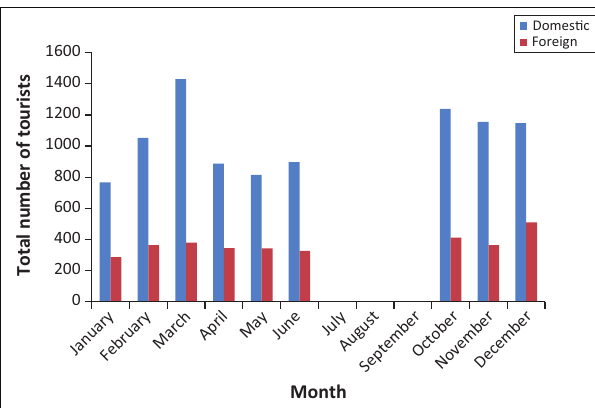
FIGURE 5: Monthly tourist arrivals at Mole National Park in the year